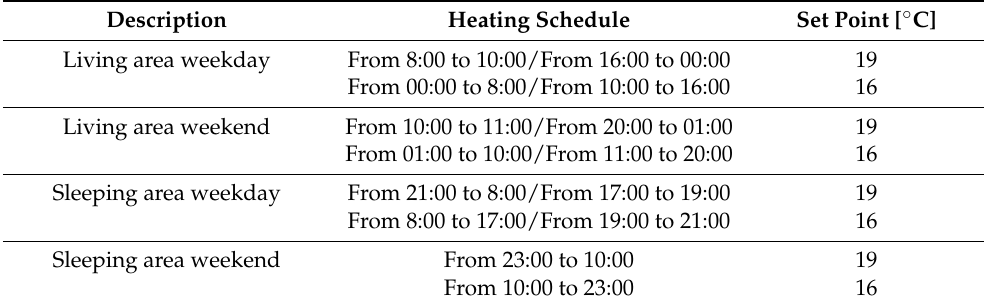
Table 5. Heating set point